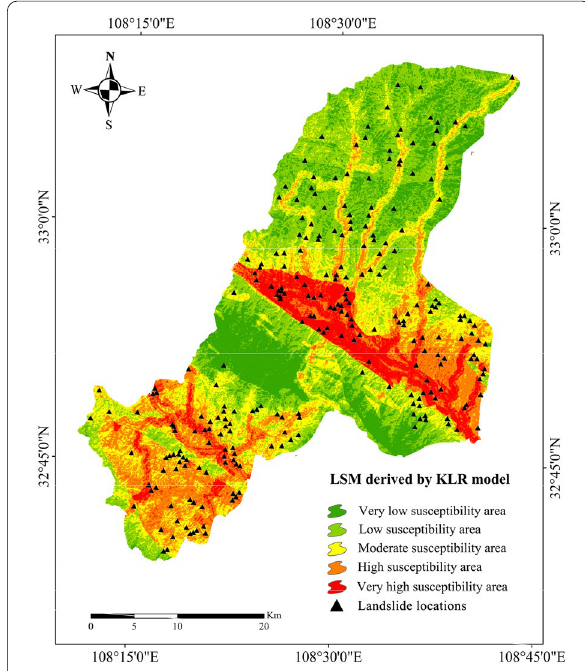
Fig. 6 Landslide susceptibility map of study area derived by KLR model